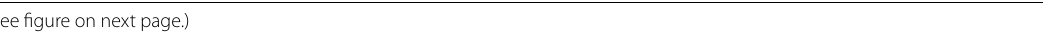
(See figure on next Fig. 3 DMAG administration enhances recovery of platelet level and function in mice with thrombocytopenia. a The KM mice were irradiated by X‑ray (4 Gy) and then treated with normal saline, TPO (3000 U/kg), or DMAG (5 mg/kg) for 14 days, respectively. The number of platelets were counted on day 0, 3, 7, 10, and 14. Each group contains 12 mice (6 male mice and 6 female mice). The data represent the mean SD of three ± independent experiments; * p < 0.05, ** p < 0.01, *** p < 0.001, compared to the corresponding model group. b MPV was measured on day 0, 3, 7, 10, and 14 in each group. c Representative images of H&E staining of BM from normal, model, TPO and DMAG groups. The yellow circles indicate megakaryocytes. Scale bar: 100 μm. The histogram indicates the number of megakaryocytes in each group. The data represent the mean SD ± of three independent experiments; * p < 0.05, ** p < 0.01, compared to the model group. d Immunohistochemical analysis of the expression of VWF in BM cells of each group. Blue represents cell nucleus. Brownness represents the expression of VWF. The histogram indicates the number of megakaryocytes in each group. The data represent the mean SD of three independent experiments; ** p < 0.01, *** p < 0.001, compared to ± the model group. e The expression of CD41 and CD61 was detected by flow cytometry in BM cells of each group. The histogram indicates the percentage of CD41 + CD61 + cells in each group. The data represent the mean SD of three independent experiments; *** p < 0.001, compared ± to the model group. f Tail bleeding time was measured after the distal tail was cut in each group. The data represent the mean SD of three ± independent experiments; ** p < 0.01, compared to the model group. g Under the stimulation of ADP, platelet aggregation was measured by a turbidimetric aggregation‑monitoring device. The histogram shows the maximum aggregation amplitude of platelets in each group. The data represent the mean SD of three independent experiments; ** p < 0.01, compared to the model group. h Micrographs of collagen‑coated slides ± with the same number of platelets perfused. The red represents platelets. The histogram shows the average coverage of red fluorescence on the whole surface by ImageJ software. The data represent the mean SD of three independent experiments; *** p < 0.001, compared to the model ± group